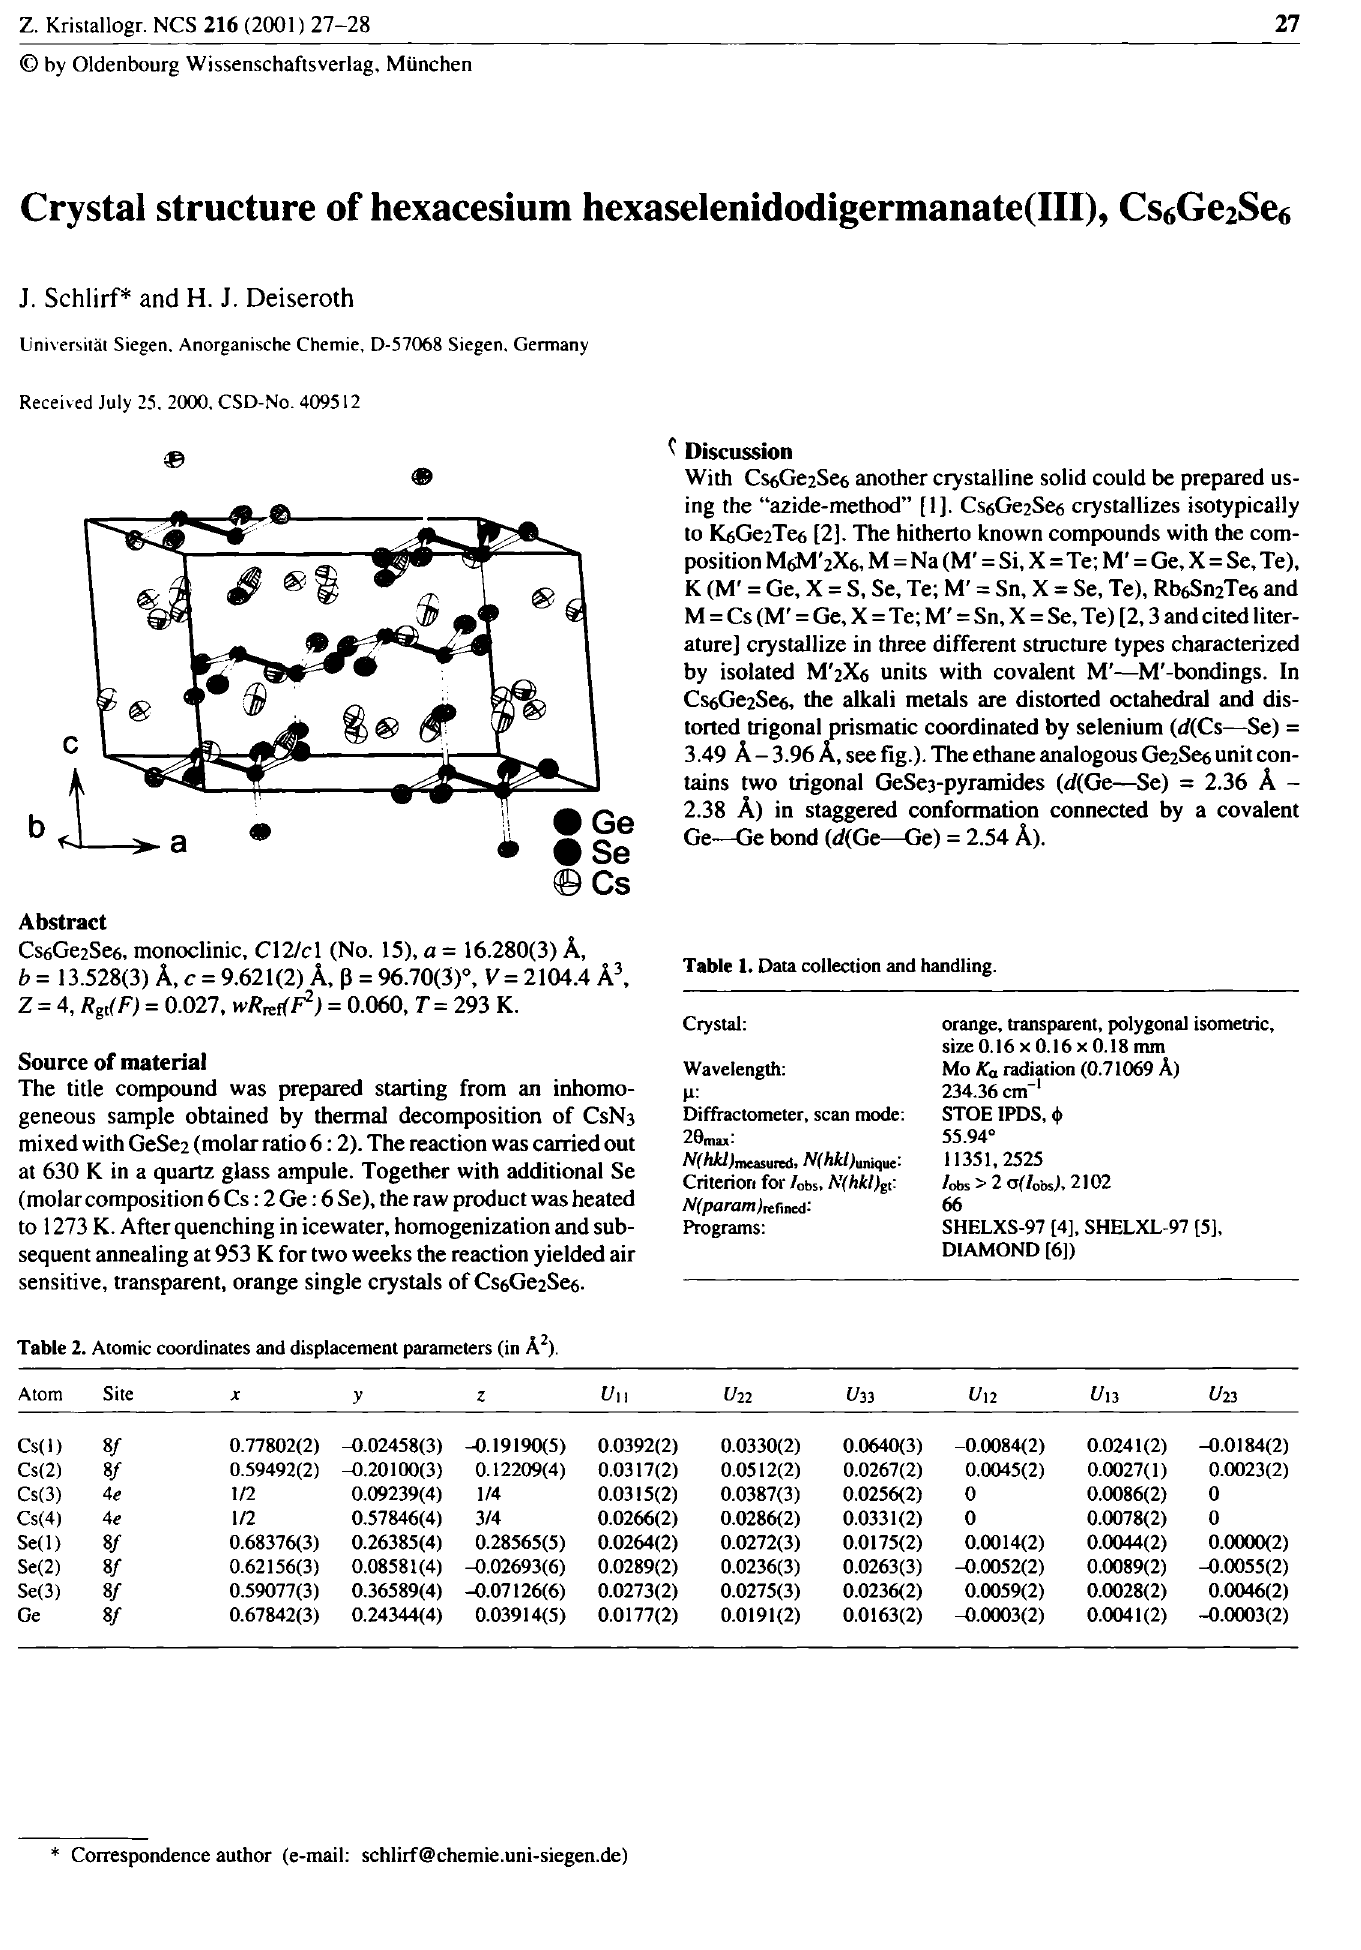
Table 2. Atomic coordinates and displacement parameters (in Ä 2 ).